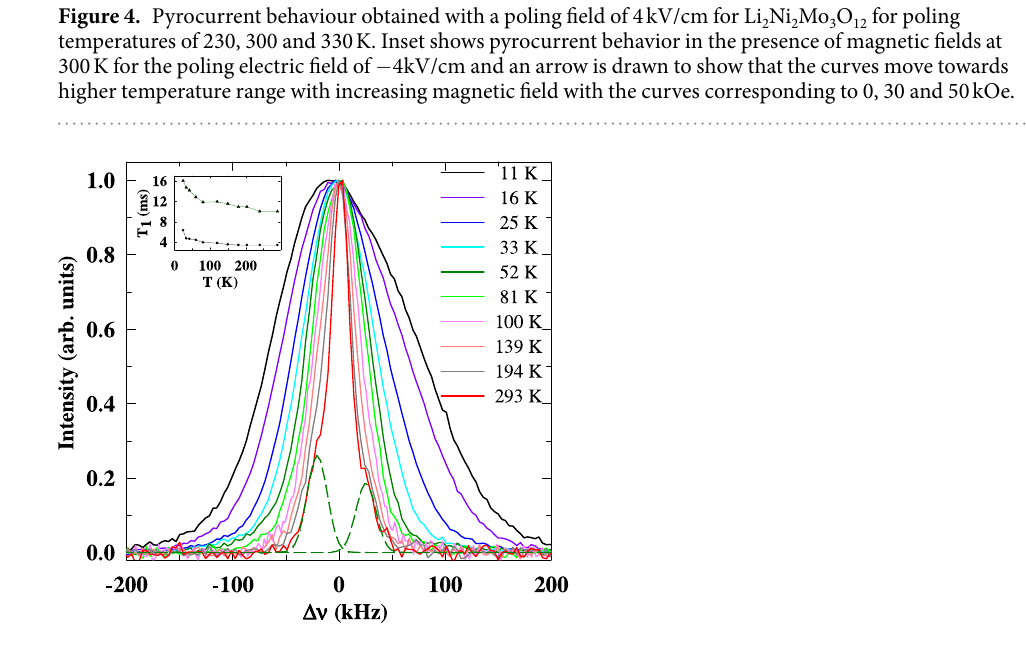
Figure 5. Temperature dependence of the 7 Li NMR spectra for Li 2 Ni 2 Mo 3 O 12 obtained at ( ν = ) 27 MHz. The origin of the x-axis Δν = 0 corresponds to the centre of the spectra at 293 K. The dotted green lines represent the asymmetric satellites at 293 K. The inset shows the T 1 variation with temperature. The solid line is guide to